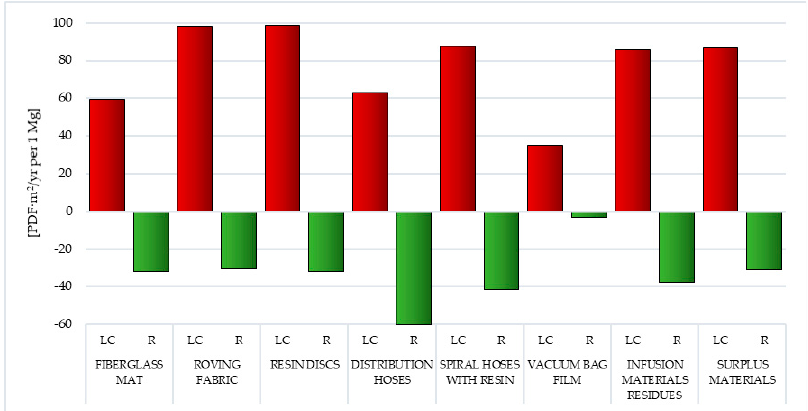
Figure 11. Characterization results of environmental consequences for compounds causing acidification or eutrophication present in selected postproduction waste of wind power plant blades: LC—life cycle, R—recycling [unit: PDF · m 2 / yr per 1